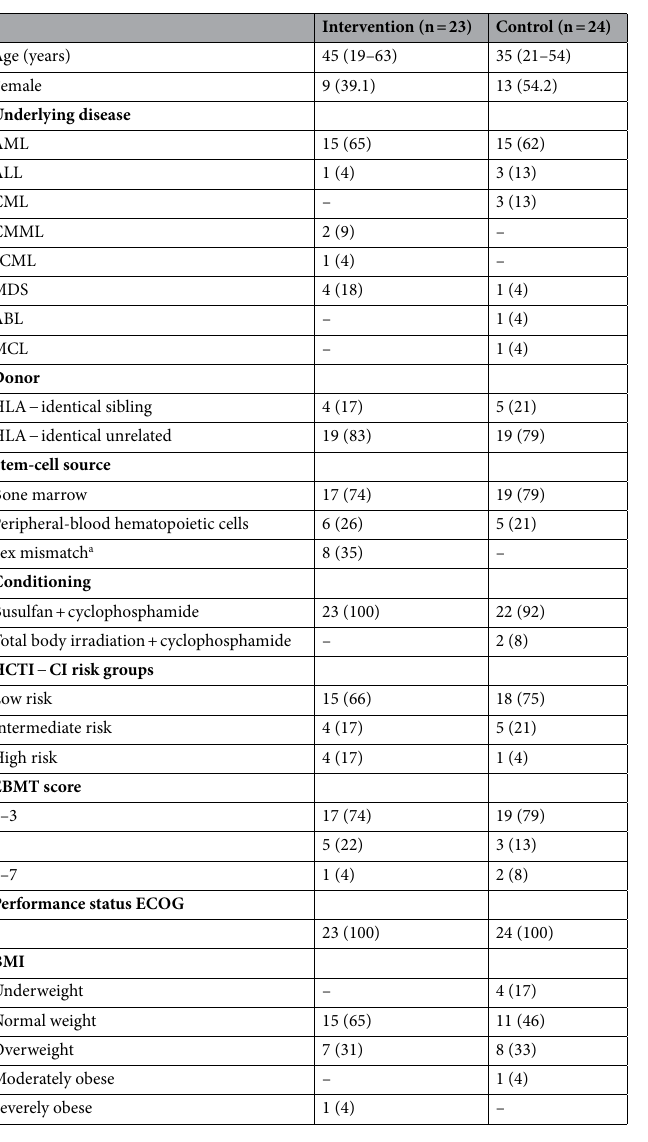
Table 1. Clinical characteristics at baseline of the two study groups. Values are numbers (%) or median (range). AML Acute myeloid leukemia, ALL Acute lymphocytic leukemia, CML Chronic myeloid leukemia, CMML Chronic myelomonocytic leukemia, aCML atypical Chronic myeloid leukemia, MDS Myelodysplastic syndrome, ABL Acute basophilic leukemia, MCL Mast cell leukemia, HCTI-CI Hematopoietic Cell Transplantation-specific comorbidity index, EBMT score European Group for Blood and Marrow Transplantation score, ECOG Eastern cooperative oncology group, BMI Body mass index. a Sex mismatch was defined as female donor-to-male